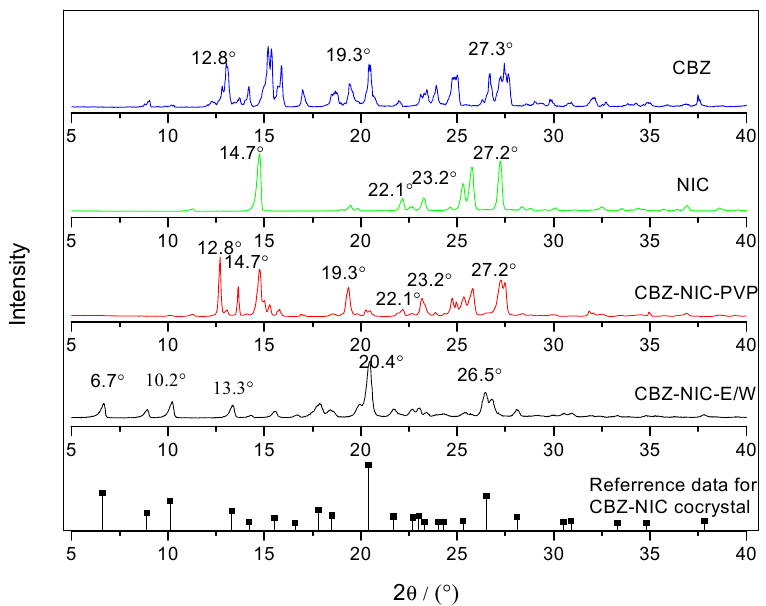
Figure 6. Powder X-ray diffraction (PXRD) spectra of CBZ, NIC, CBZ-NIC-PVP, CBZ-NIC-E/W, and CBZ-NIC-cocrystal.